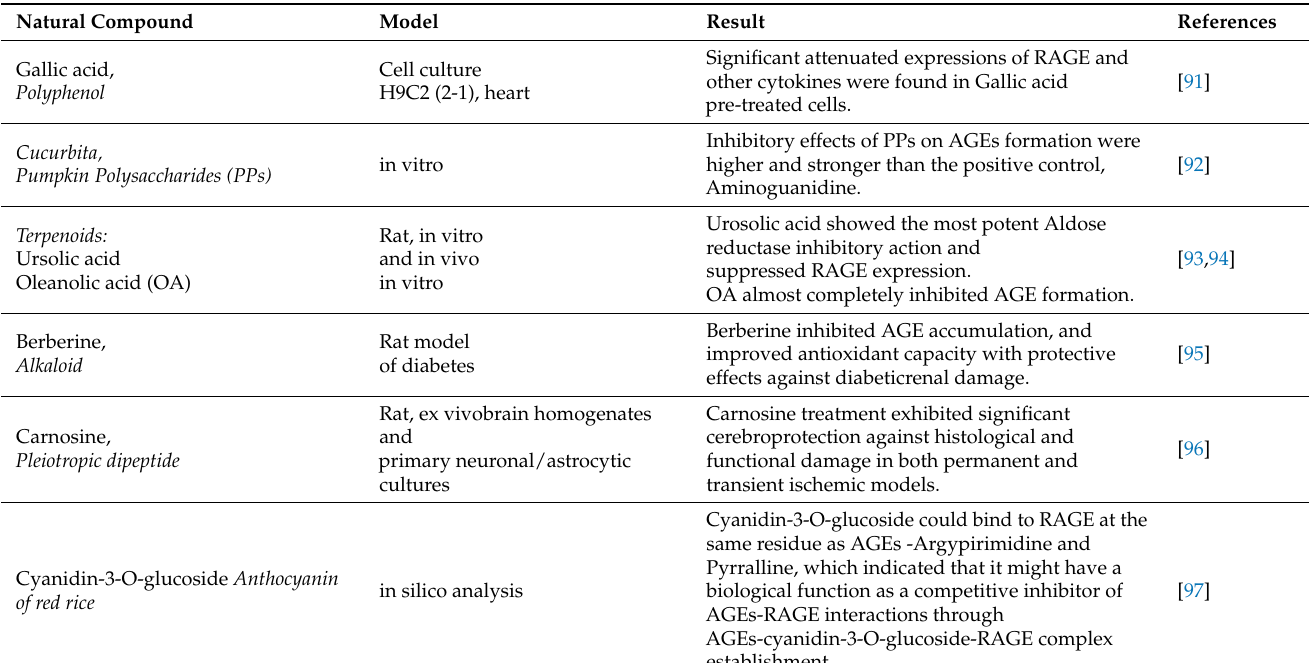
Table 5. Experimental findings on natural compound-based AGE–RAGE inhibitors against diabetic, cardio-, and cerebrovascular